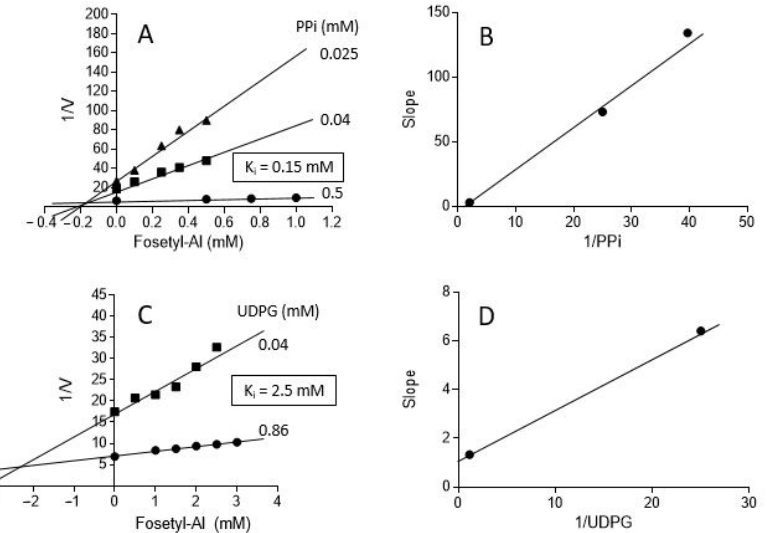
Figure 5. Fosetyl-Al inhibition of barley UGPase pyrophosphorolytic activity at varied PP i or UDPG. ( A ) UGPase activity (V) was assayed with varied concentrations of fosetyl-Al, at three different PP i concentrations and with UDPG fixed at 0.86 mM. ( B ) Slopes of the lines from panel ( A ) versus 1/[PP i ]. ( C ) UGPase activity (V) was assayed with varied concentrations of fosetyl-Al, at two different concentrations of UDPG and with PP i fixed at 0.5 mM. ( D ) Slopes of the lines from panel ( C ) versus 1/[UDPG]. Please see the text for rationale for ( B , D ) panels.